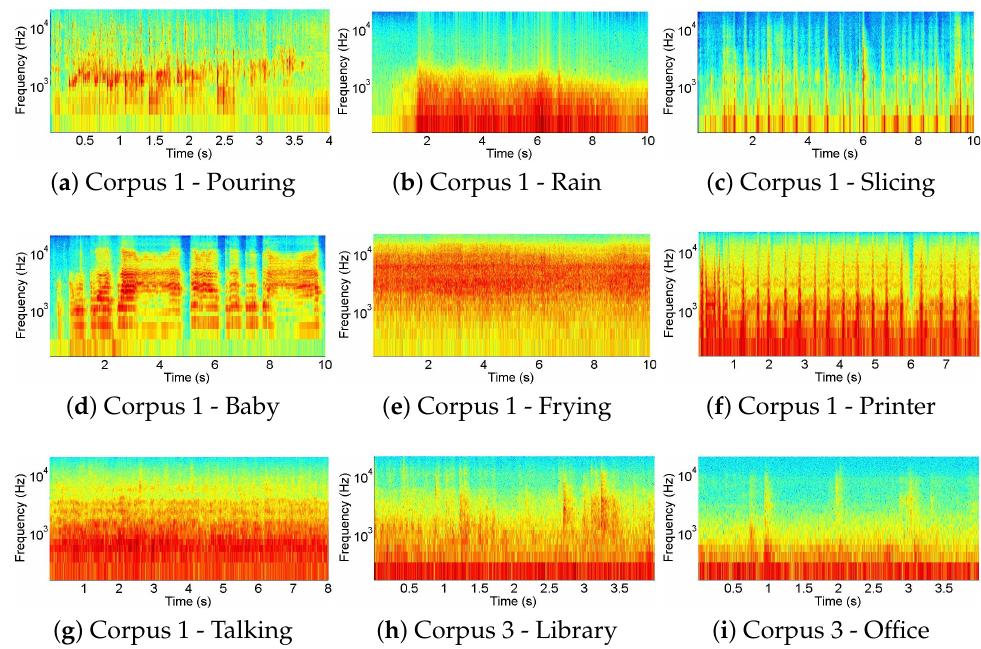
Figure 6. Selection of spectrograms of the most often mis-classified classes in the corpora for illustrative purposes. The temporal window varies between approximately 4 and 10 s, but the vertical axis (Hz) is